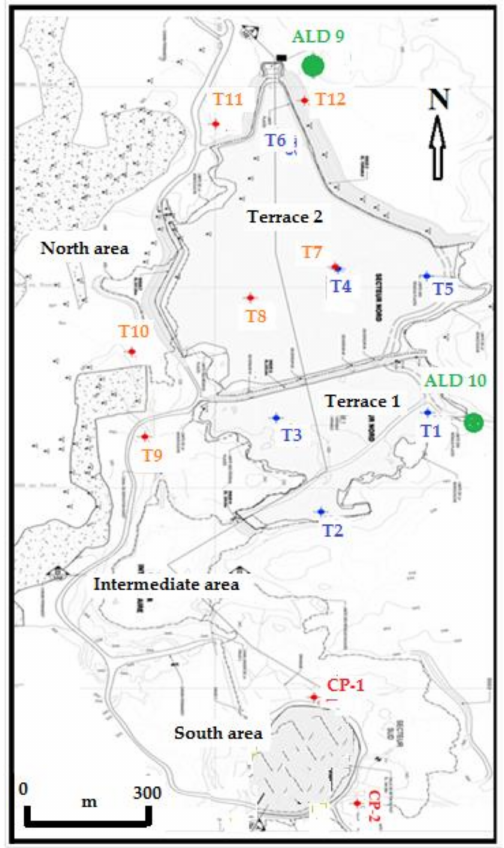
Figure 2. Location of different sectors at the Aldermac mine site (modified from [27]): T1 to T11 and CP-1 and CP-2 are piezometers; ALD 9 and ALD10 are the water effluent of the mine